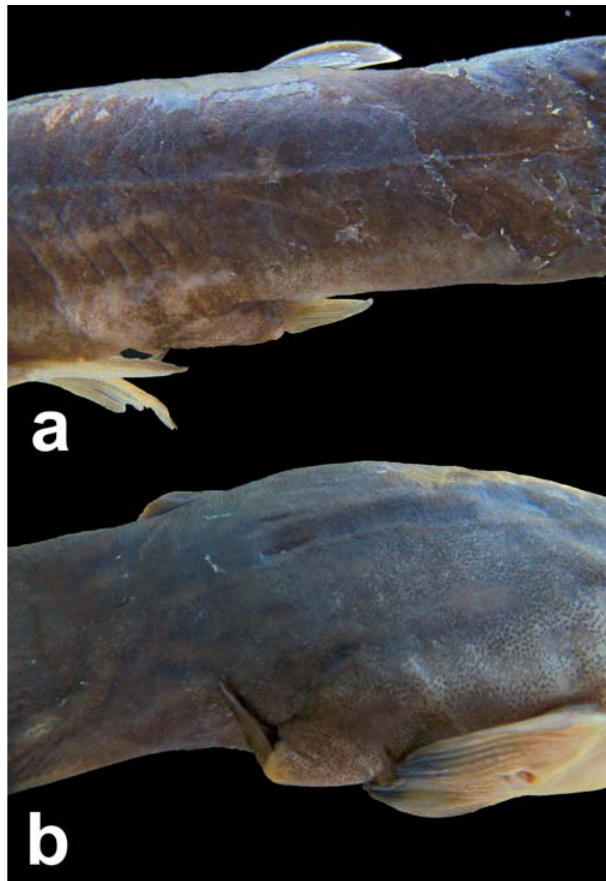
Fig. 39. Detail of male modified anal fin in Tatia nigra. (a) INPA 11081, male, 107.8 mm SL, anal fin parallel to body. (b) INPA 11081, male, 105.2 mm SL, anal fin spoon shaped and laterally